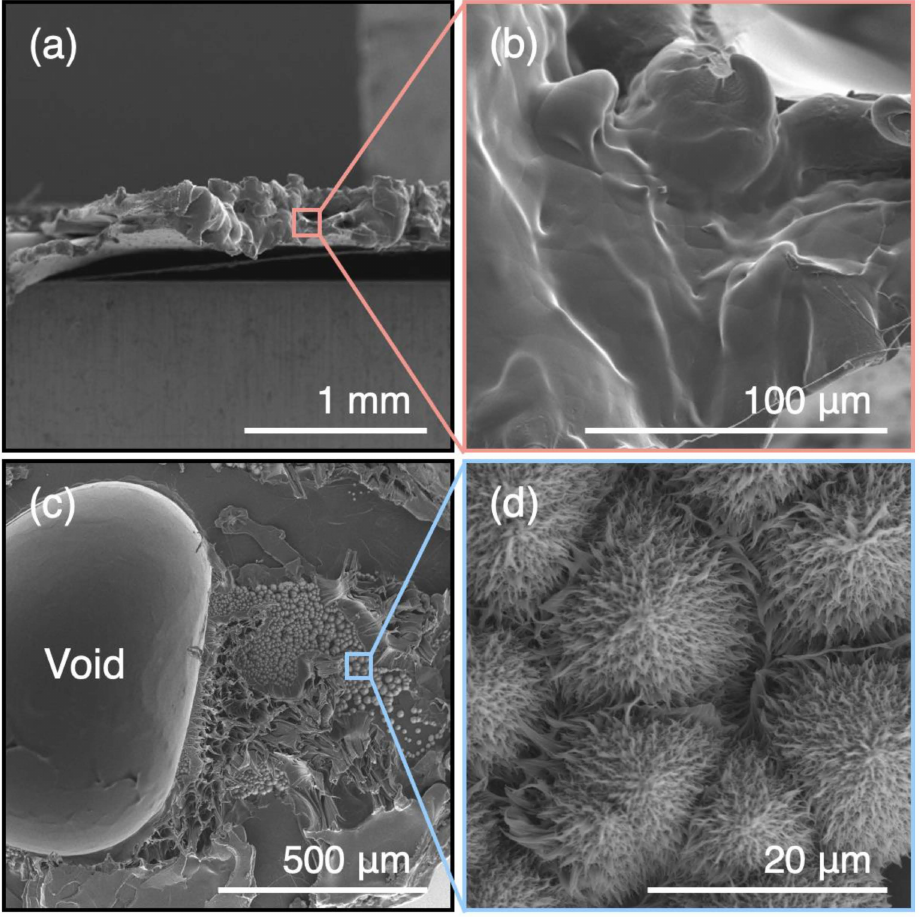
Figure 5. FE–SEM images of the fracture surface of PBS specimens ( a , b ) after fabrication and ( c , d ) 56 days after the start of the decomposition